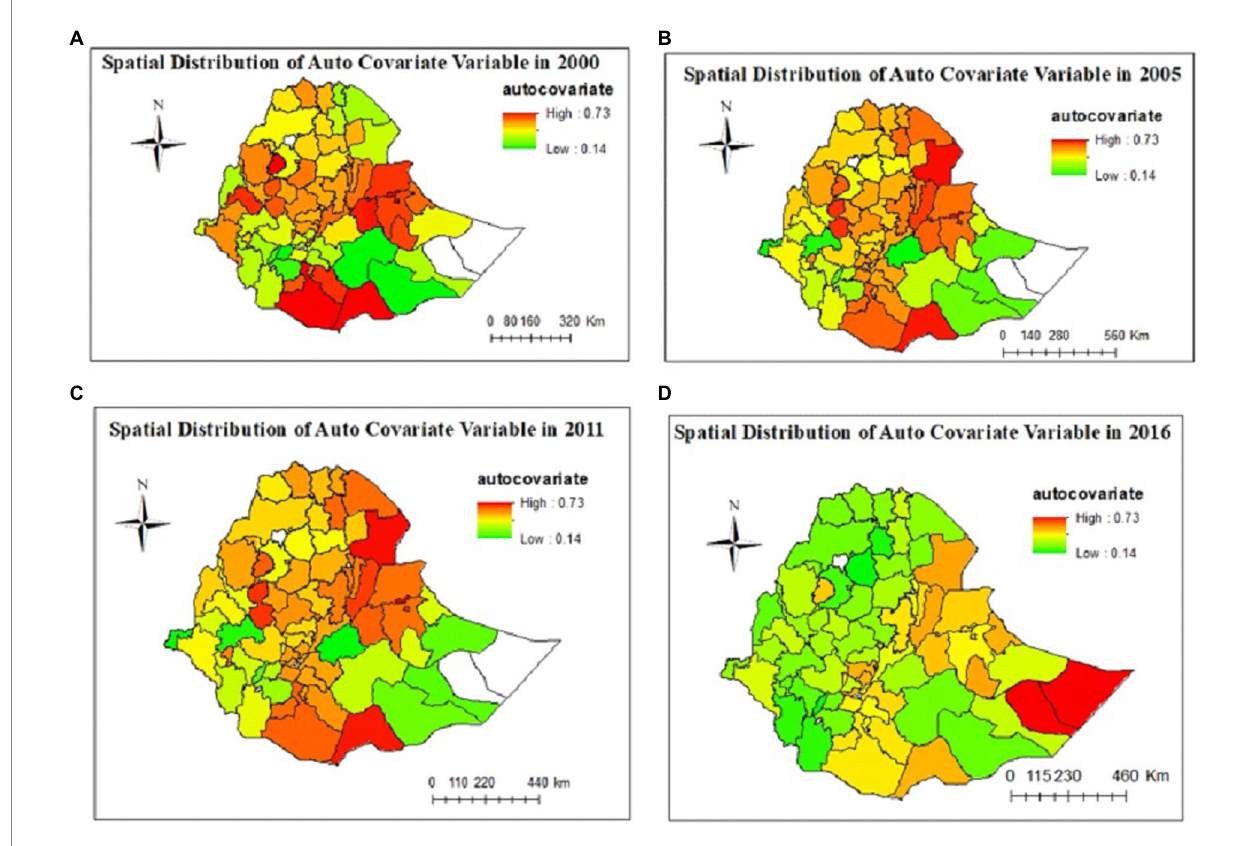
FIGURE 4 Predicted spatial effects of SBI in Ethiopian administrative zones and temporal trend in years (A) 2000, (B) 2005, (C) 2011, and (D)